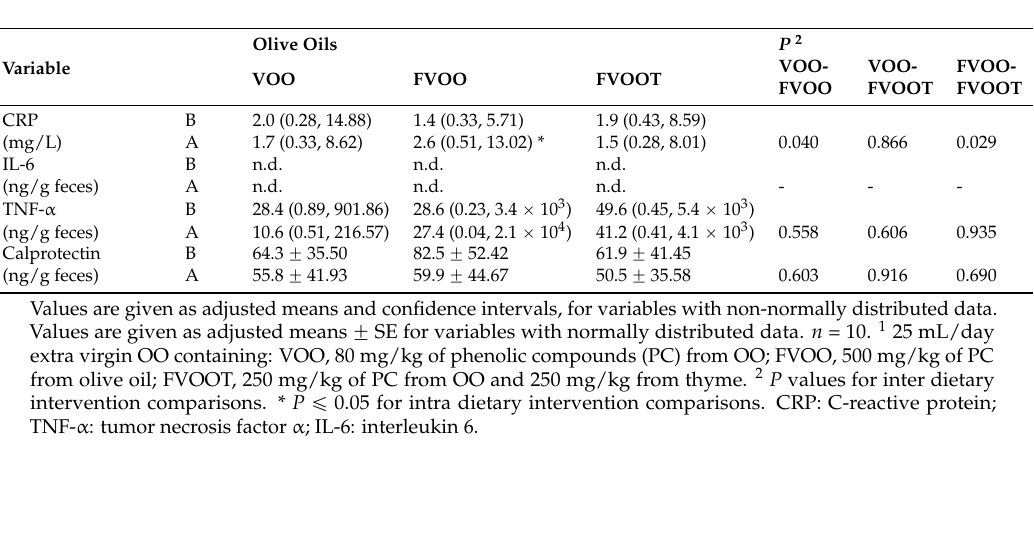
Table 3. Inflammatory markers before (B) and after (A) each olive oil intervention 1